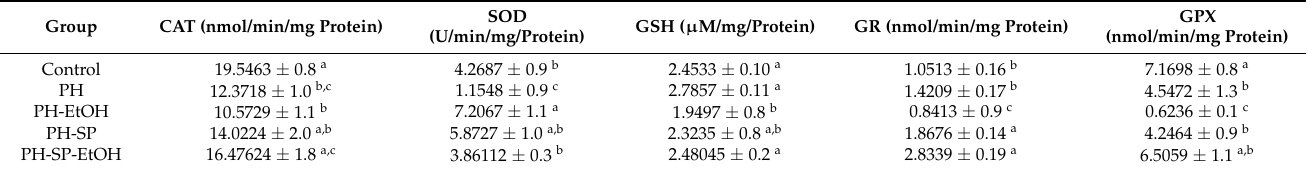
Table 4. Activity of antioxidant enzymes in the liver of rats treated with EtOH and SP. Values are mean ± SEM. Number (n) of animals per group =